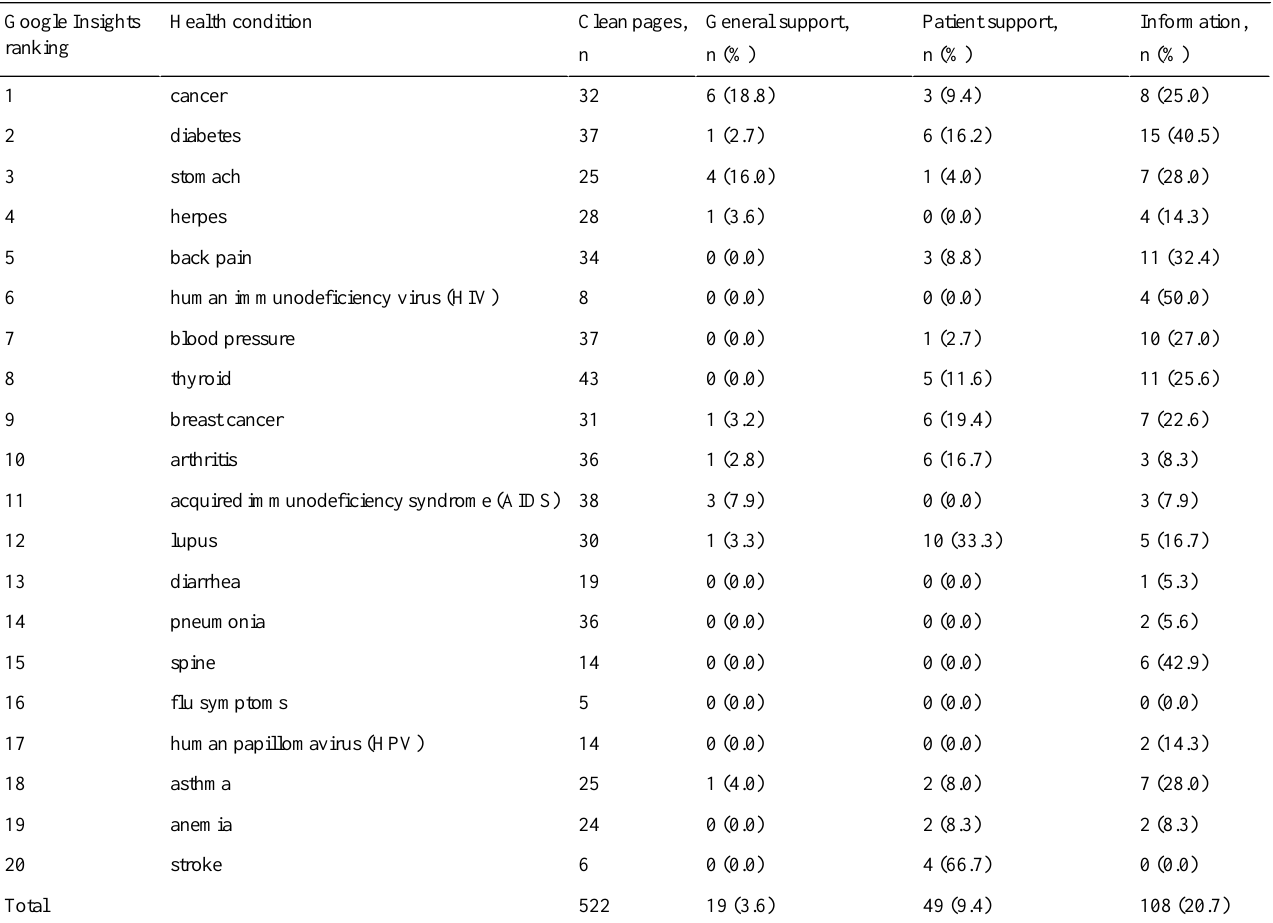
Table 4. Facebook pages by health condition and content—General Support, Patient Support, and Information/Awareness.